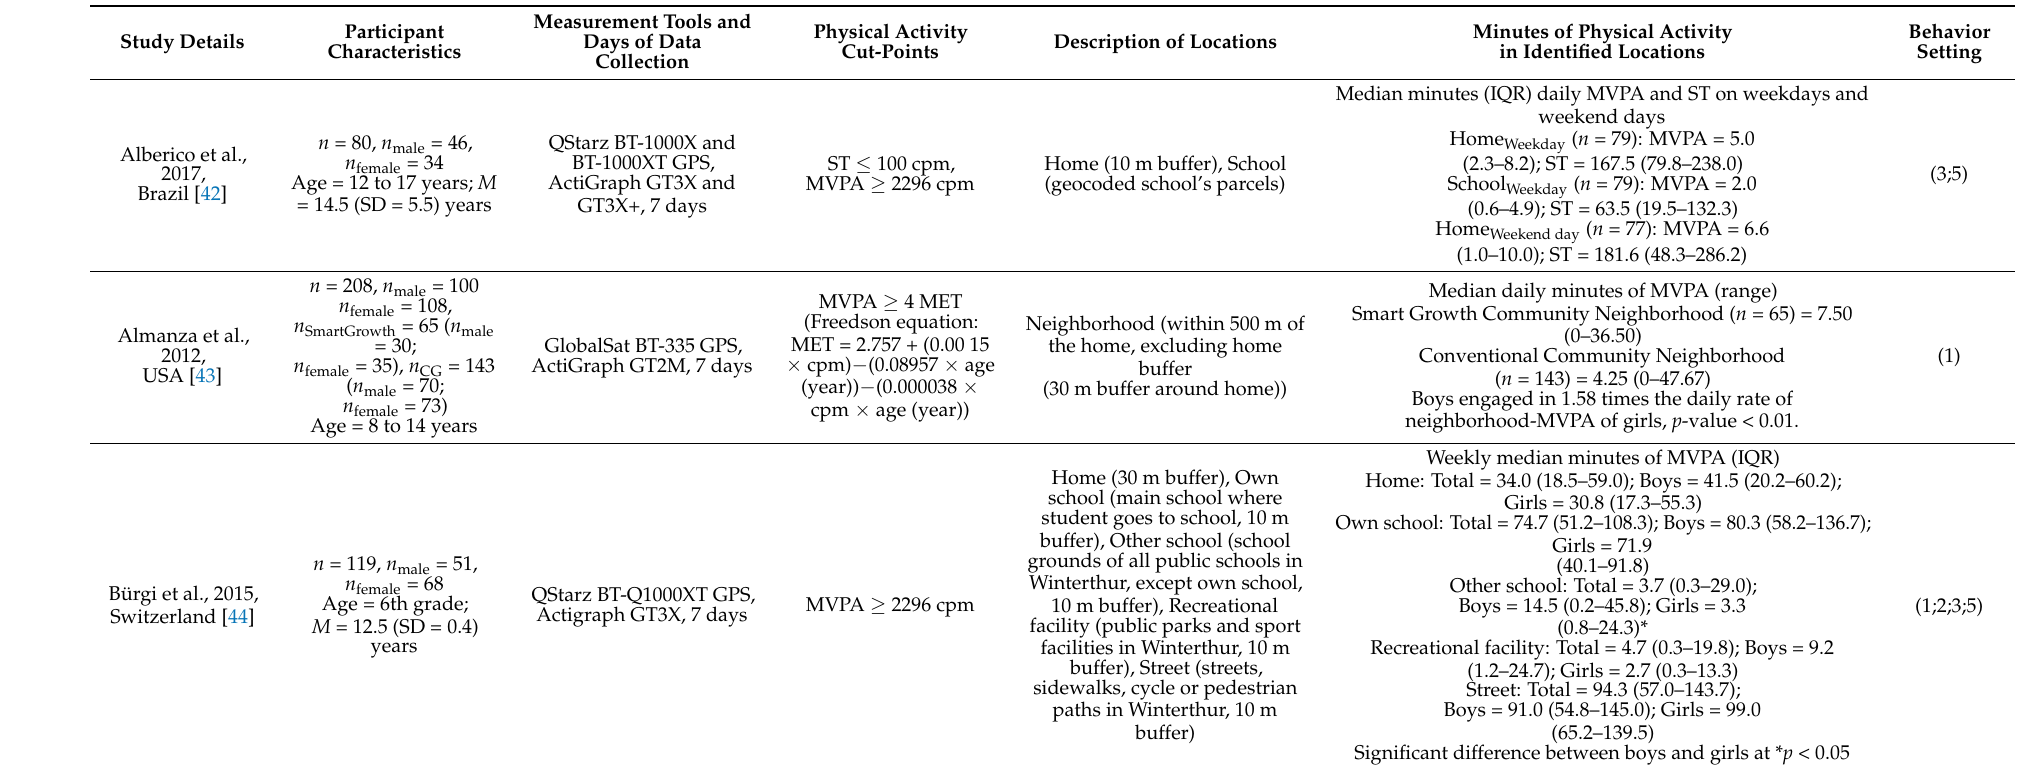
Table 1. Description of included studies targeting children and adolescents and summary of main